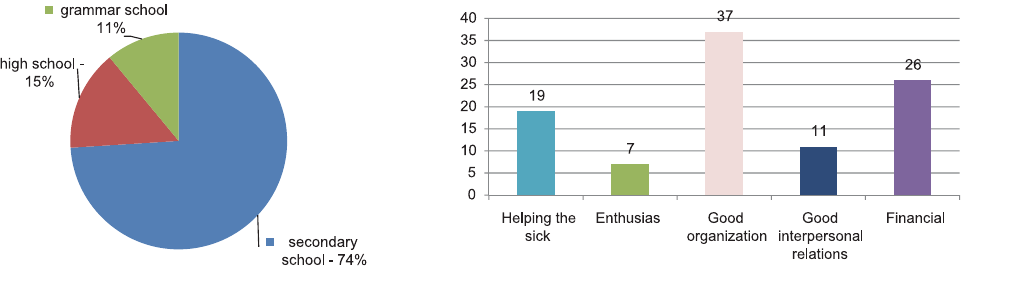
FIGURE 3. Distribution of respondents by education FIGURE 4. Motivation for working with dif fi cult patients